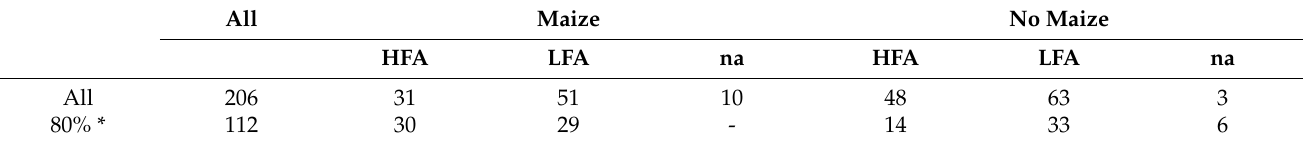
Table 3. Study design (number of FNNs) according to maize and wild fruit